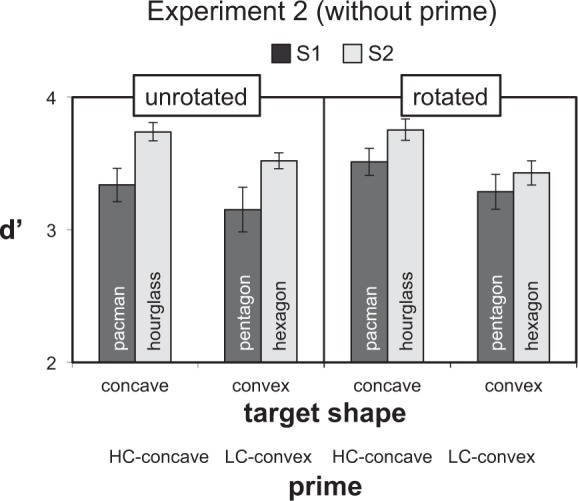
Experiment 2. Mean d′ values in the Rotation × CCP ×
Symmetry design. The pattern was only partially similar to the one
for response speed in Experiment 2, shown in Figure A.5.